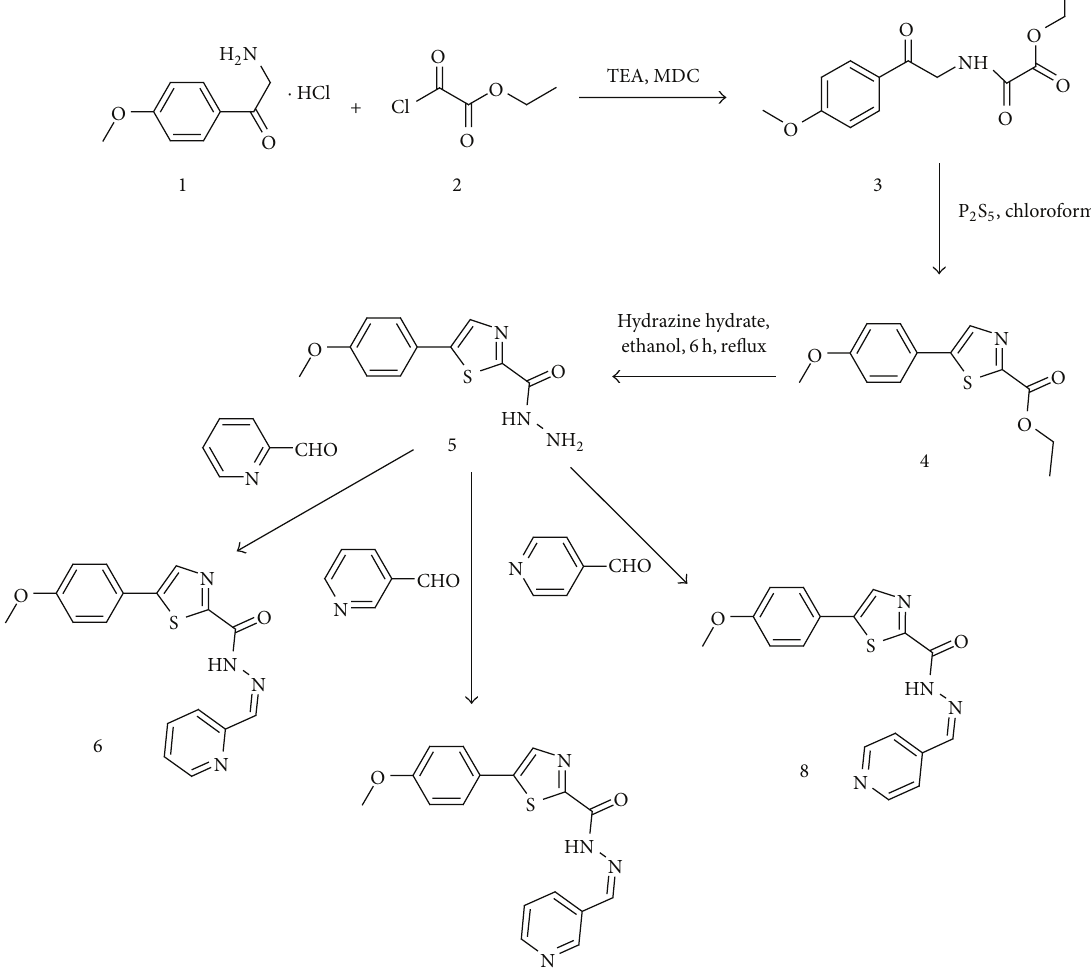
Figure 1: Scheme for the synthesis of